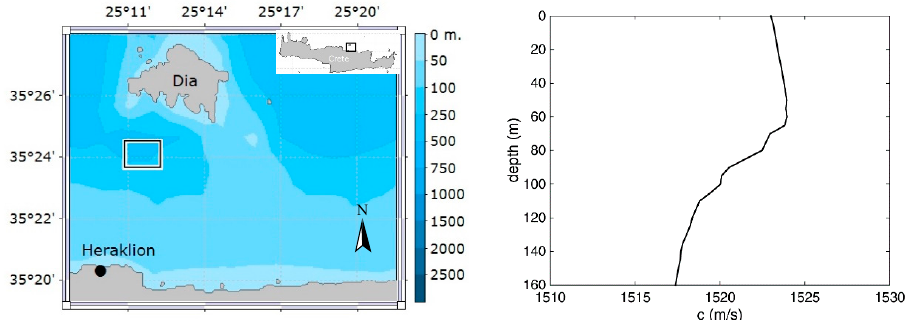
Figure 1. Area of the shallow-water localization experiment in the Bay of Heraklion ( left ), and measured sound speed profile ( right ).